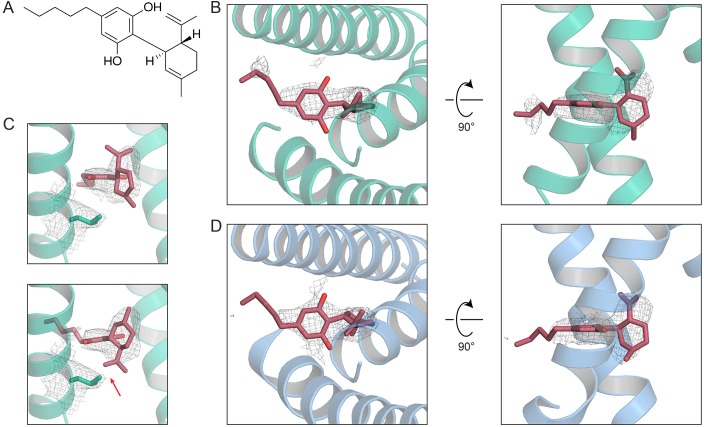
CBD fit in the cryo-EM map.(A) Chemical diagram of cannabidiol (CBD). (B) Fit of CBD into the TRPV2CBD_1 map. (C) Comparison of two poses of CBD in the TRPV2CBD_1 map. The residue shown in sticks is Leu537. The red arrow indicates a clash. (D) Fit of CBD into the TRPV2CBD_2 map.